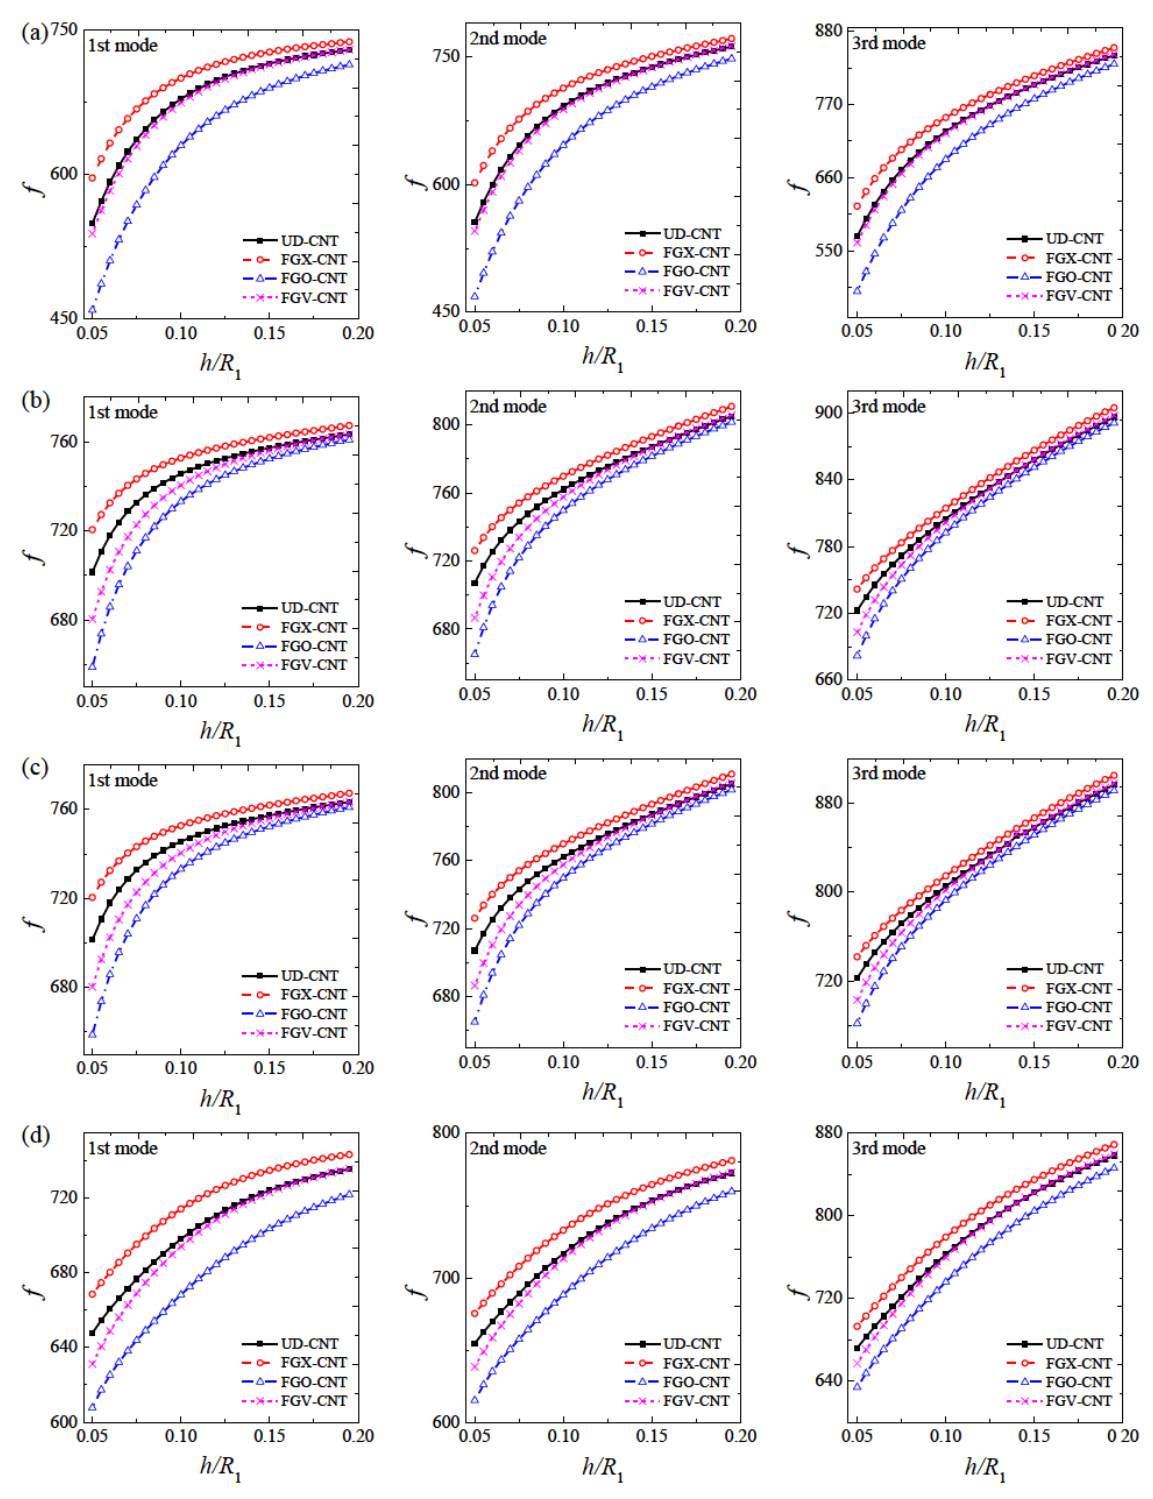
Figure 9: Variation of the first four frequency parameters Ω versus the thickness ratios for FG-CNT reinforced composite annular sector plates:(a) SSSS; (b) CCCC; (c) CE 1 CE 1 ; (d) E 3 E 3 E 3 E